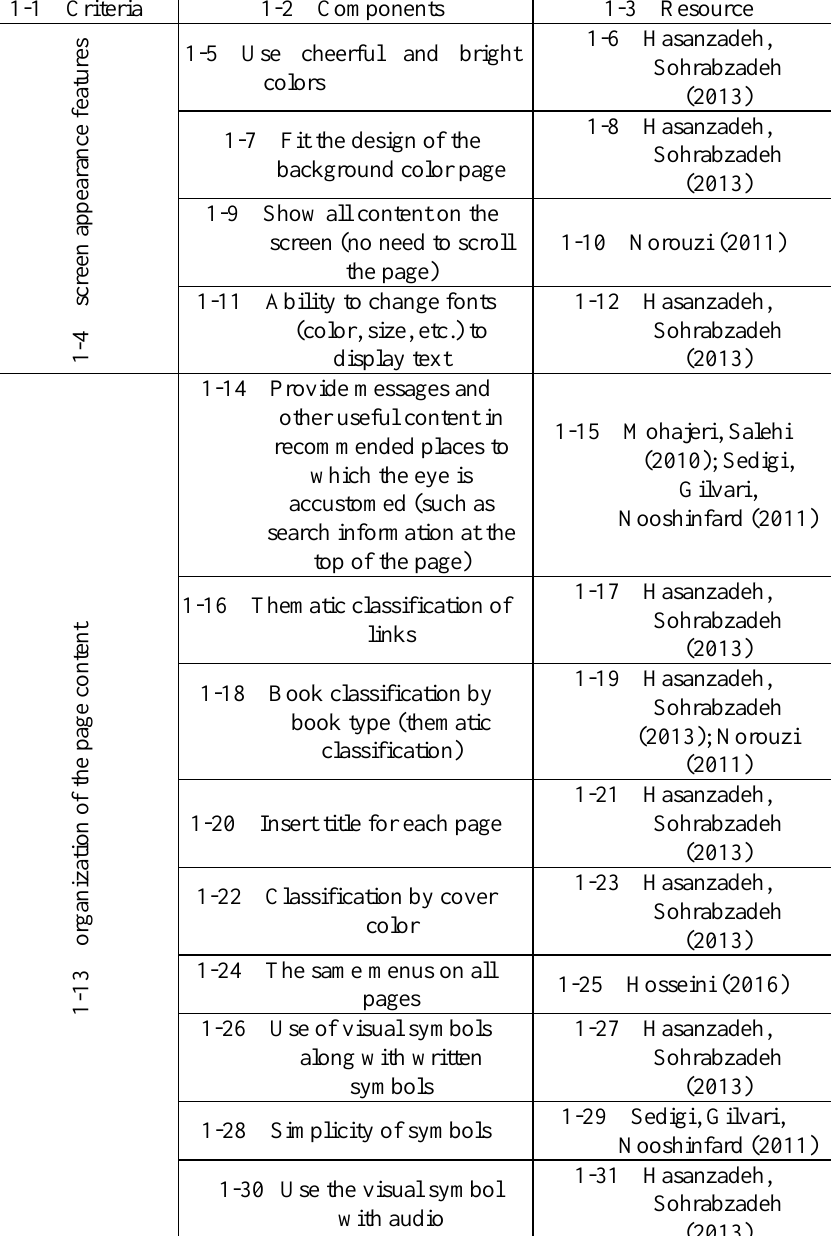
Table 3. Components of e-book reading system derived from reading